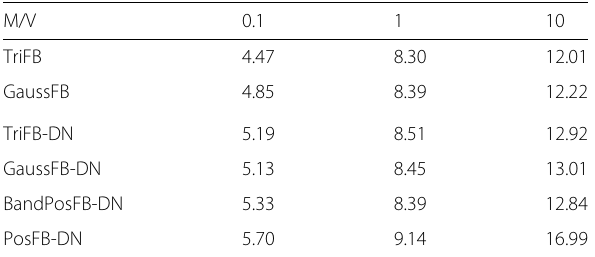
Table 4 Reconstruction SDR of audio source separation in decibel. M/V represents the energy ratio between music and